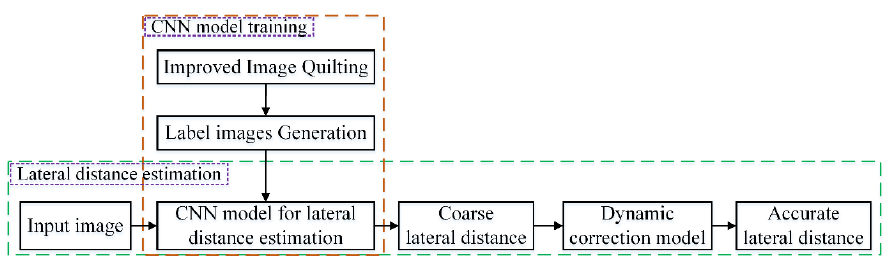
Figure 1. The flowchart of the algorithms. The “convolution neural network (CNN) model training” included label images generation method and model training. The “Lateral distance estimation” detects the lateral distance in the input image by using the trained model, and the bigger error was reduced through the dynamic correction model.